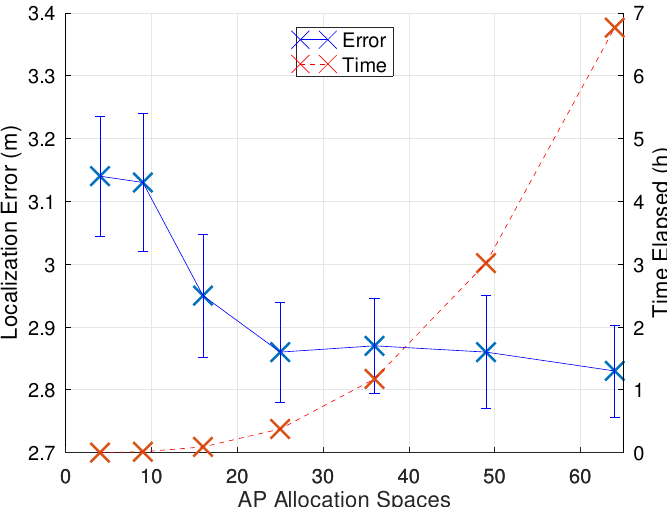
Figure 11. Influence of the number of AP allocation spaces on 95% of cumulative error (solid line) and CPU time elapsed (dashed line). Scenario considered: 3 APs, 16 RPs and 10 samples per test. One way to set a fixed value for n c is to use the rule of thumb presented